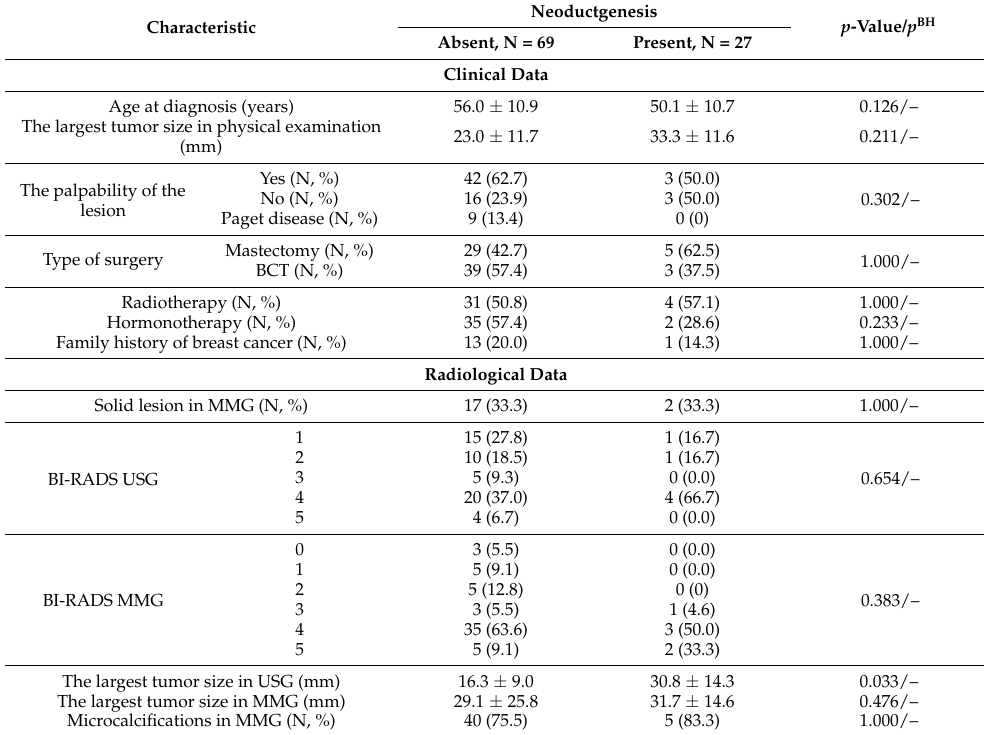
Table 5. Clinical and radiological characteristic of DCIS with or without neoductgenesis as scores